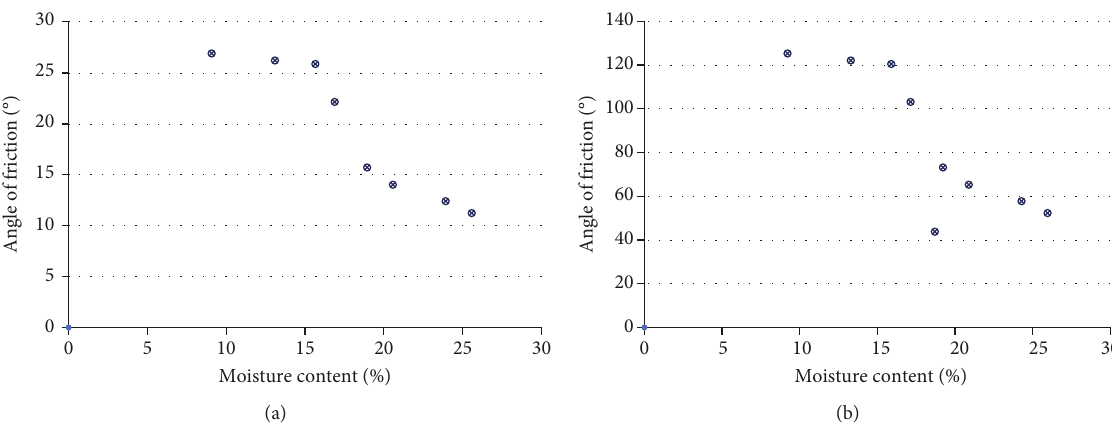
Figure 9: E ff ect of moisture on strength